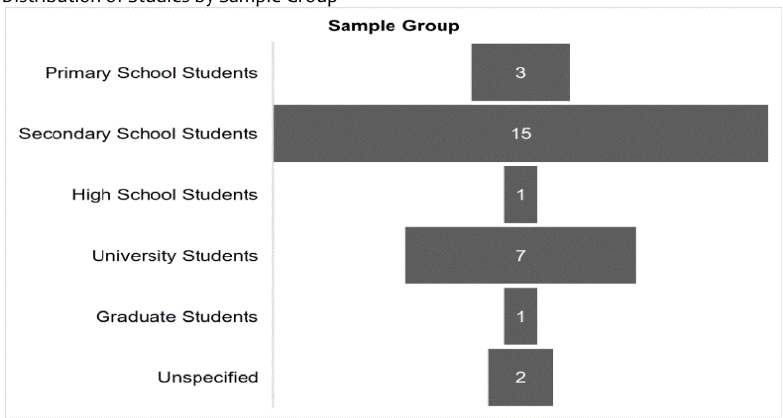
Figure 5: Distribution of Studies by Sample